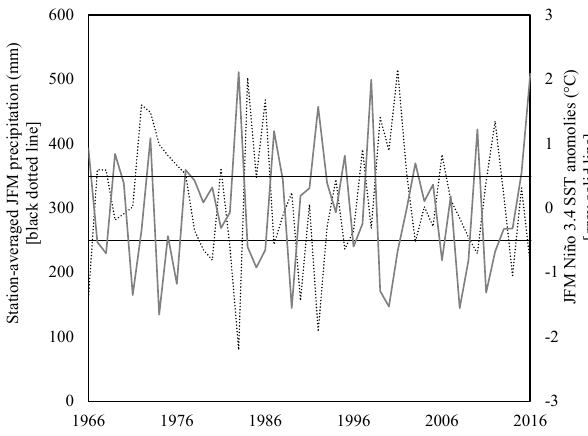
Figure 4. Station-averaged JFM precipitation (mm) and the first PC anomalies for the period of record, 1966–2016, using data from 29 precipitation stations (introduced in Sect. 2).